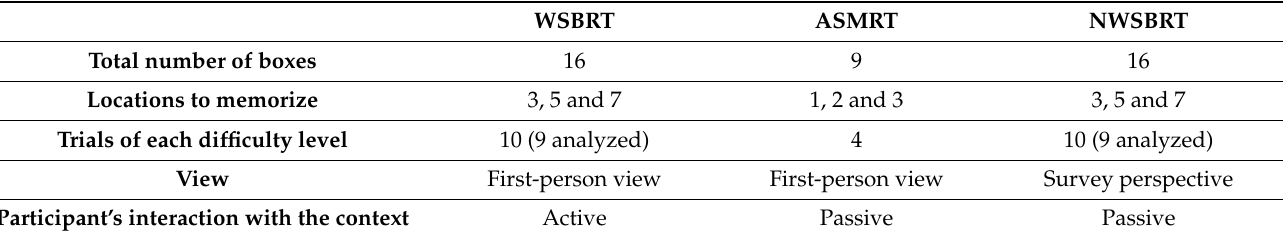
Figure 3. ASMRT: Example of a memorizing image ( A ) and a recognition image ( B ). The answer is correct and partic- ipants should press the “yes” key because the green box in the recognition image occupies the same location as in the memorizing image. Table 2. Scheme of the three spatial